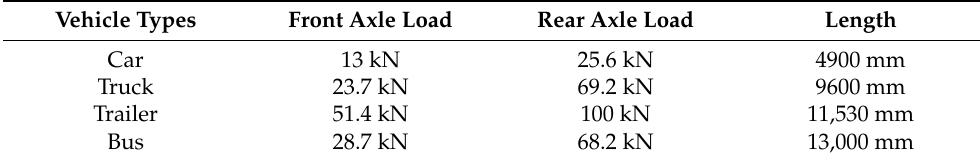
Table 7. Vehicle information.